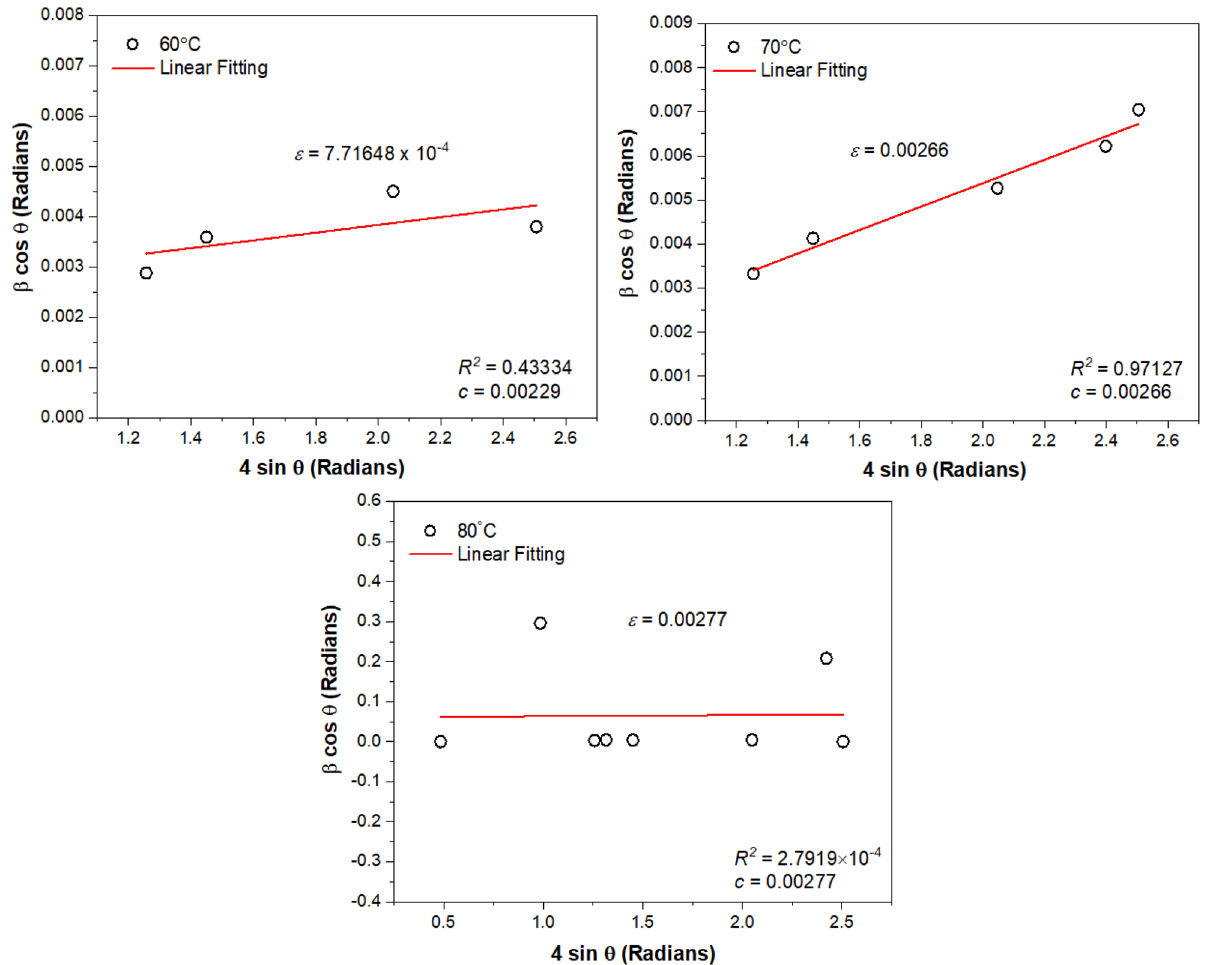
Figure 10. Linear fitting calculated using W–H correlation for Cu-based oxide nanostructures prepared 60, 70 and 80 °C. The slope indicates the mean microstrain, ε and the intercept line at the y-axis, c manifest the inverse of D m